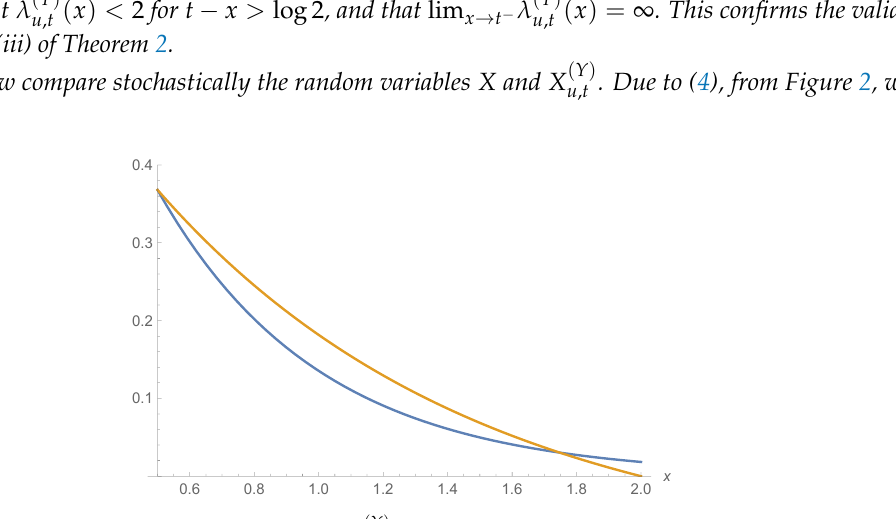
( Y ) (from bottom to top near x = 1) for the random u , t